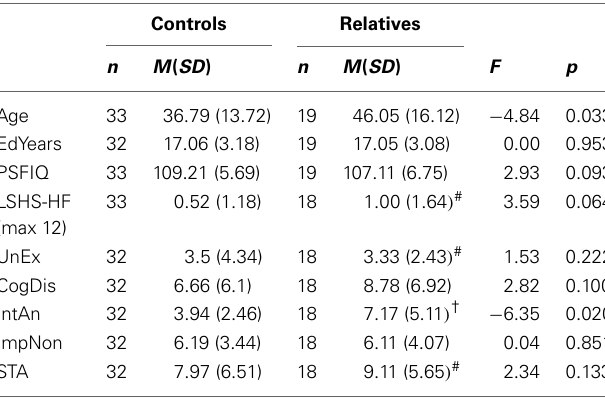
Table 1 | Mean (standard deviation) of demographic characteristics for controls and relatives.